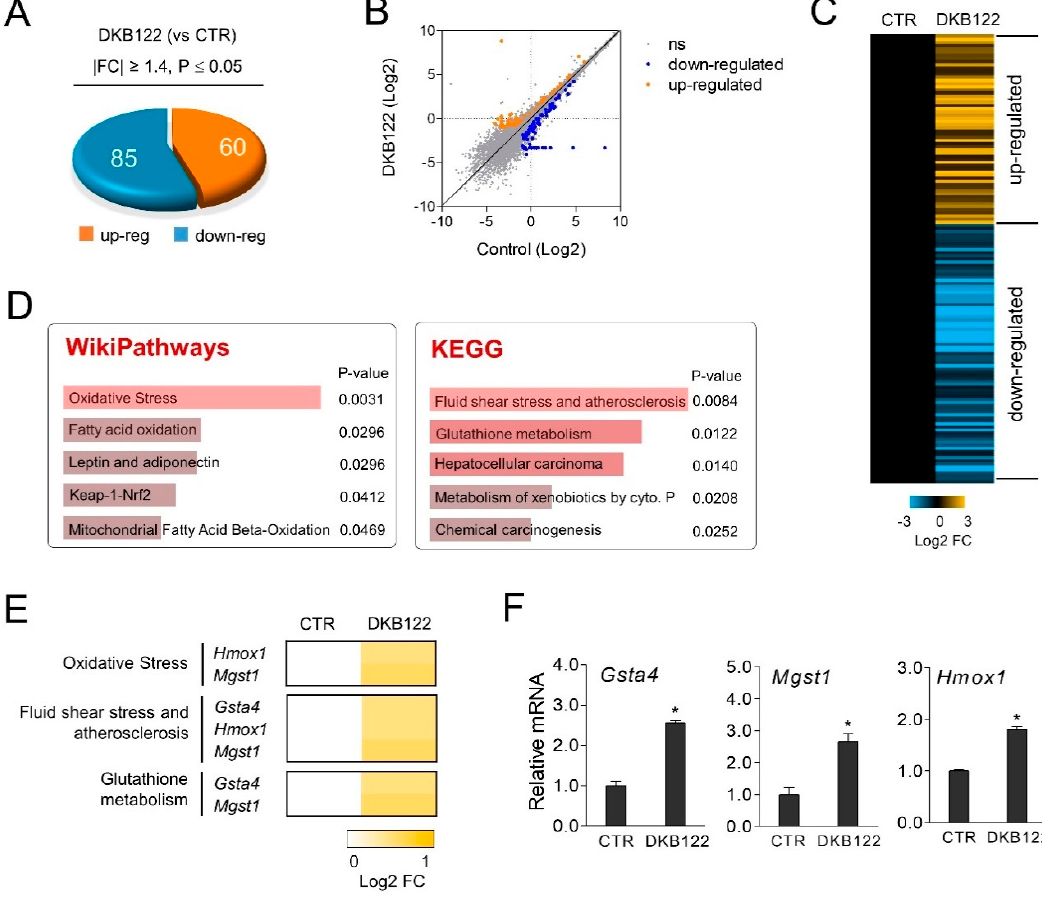
Figure 2. Activation of antioxidant gene expression by DKB122 in HEI-OC1 cells. ( A , B ) RNA-seq of DKB122 (25 µ g / mL, 24 h) in HEI-OC1 cells. 85 up-regulated and 60 down-regulated genes are shown in the pie chart and scatter plot. ( C ) Heat map of gene expression changes resulting from DKB122 treatment. ( D ) Pathway analyses (WikiPathways and KEGG) of di ff erentially expressed genes after DKB122 treatment in HEI-OC1 cells. ( E ) Heat map of genes responsible for the induction of oxidative stress, fluid shear stress, atherosclerosis, and activation of the glutathione metabolic pathway. ( F ) HEI-OC1 cells were treated with DKB122 (25 µ g / mL) for 24 h prior to harvesting. Total RNA was examined by RT-qPCR. mRNA levels were normalized to 18S rRNA. Gsta4 , Glutathione S-Transferase Alpha 4; Mgst1 , Microsomal Glutathione S-Transferase 1; Hmox1 , Heme Oxygenase 1. The results are presented as mean ± SD of three independent experiments ( n = 3, * p < 0.05).